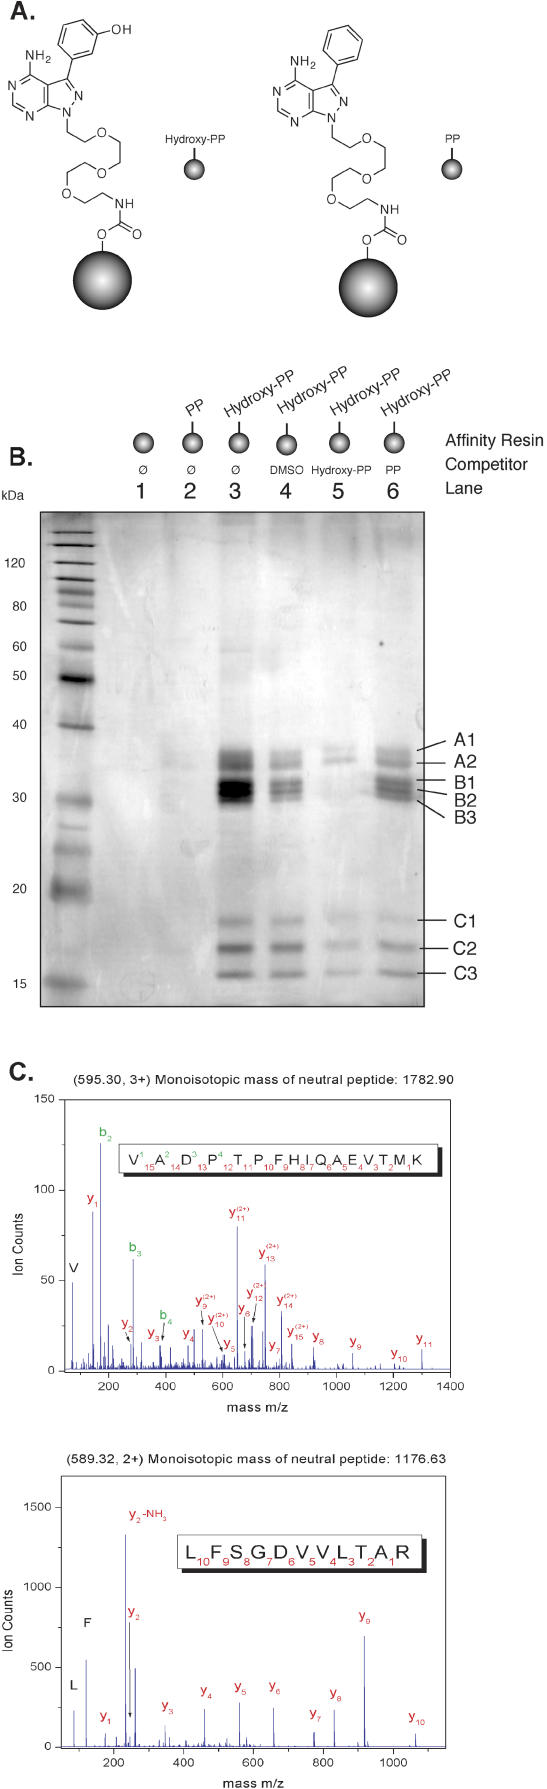
Affinity Purification and Identification of Human CBR1(A) Reactigel beads appended with hydroxy-PP or PP (control) were used for affinity purification of hydroxy-PP protein targets.(B) Hydroxy-PP-binding proteins in A549 cell lysates. Cytosolic fractions of A549 cell lysate (1.7 mg protein each) were incubated with the indicated affinity resin, and bound proteins were resolved by SDS-PAGE (12% acrylamide gel) followed by silver staining. Untreated beads and PP-control resin samples (lanes 1 and 2) indicate little nonspecific binding. Lanes 3, 4, 5, and 6 were loaded using the hydroxy-PP resin incubated with cell lysate and the indicated competitor. Vehicle or competitor compounds (200 μM) were added to the lysate 30 min before incubation with beads (lanes 4–6). Protein of bands B1–B3 did not bind hydroxy-PP beads when pretreated with hydroxy-PP (lane 5).(C) MS/MS peptide sequencing. Two tryptic peptides from bands B1–B3 were used to identify human CBR1.